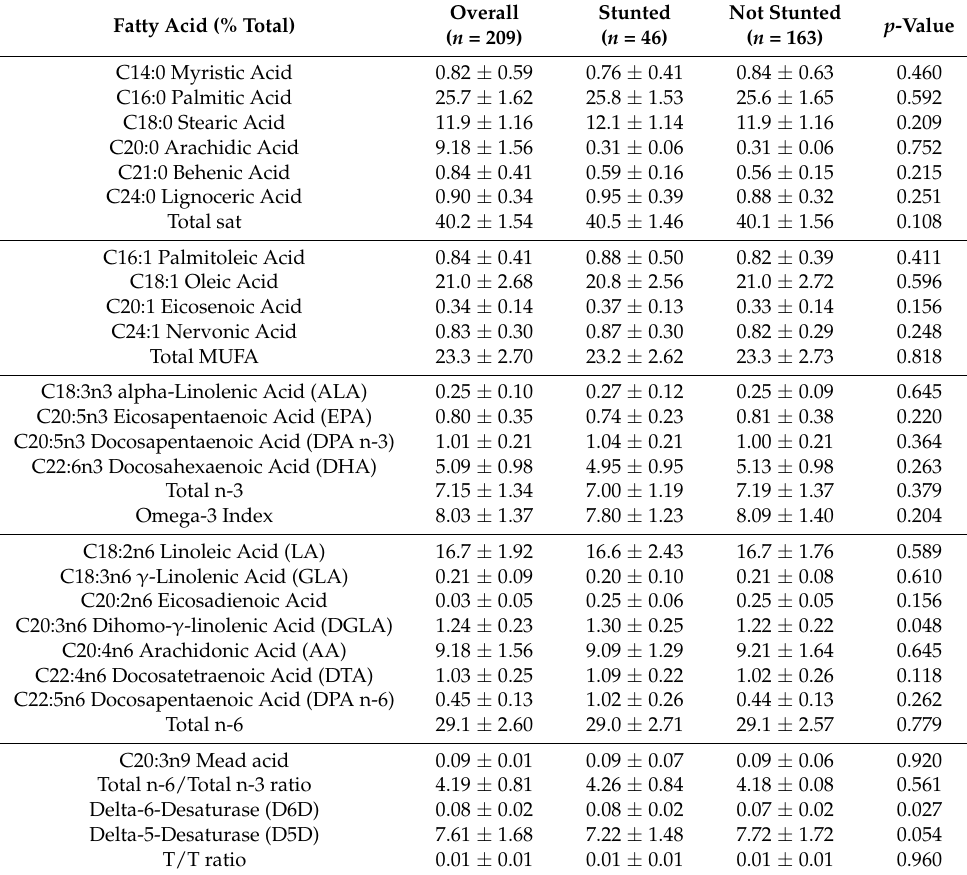
Table 3. Mean fatty acid levels of overall, stunted and non-stunted children in southern Ghana (Values expressed as mean ± standard